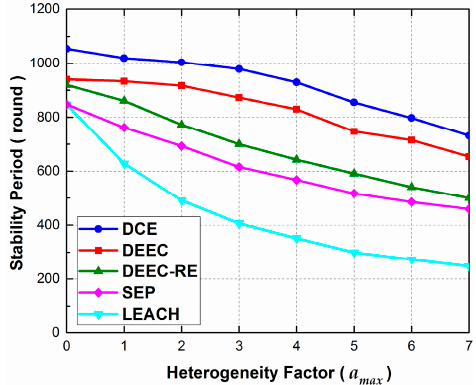
Figure 5. The effect of heterogeneity factor a max on stability period in Scenario 2. Note that, in this scenario, the total energy of the network is the same as that in Scenario 1, and just the energy heterogeneity is changed.